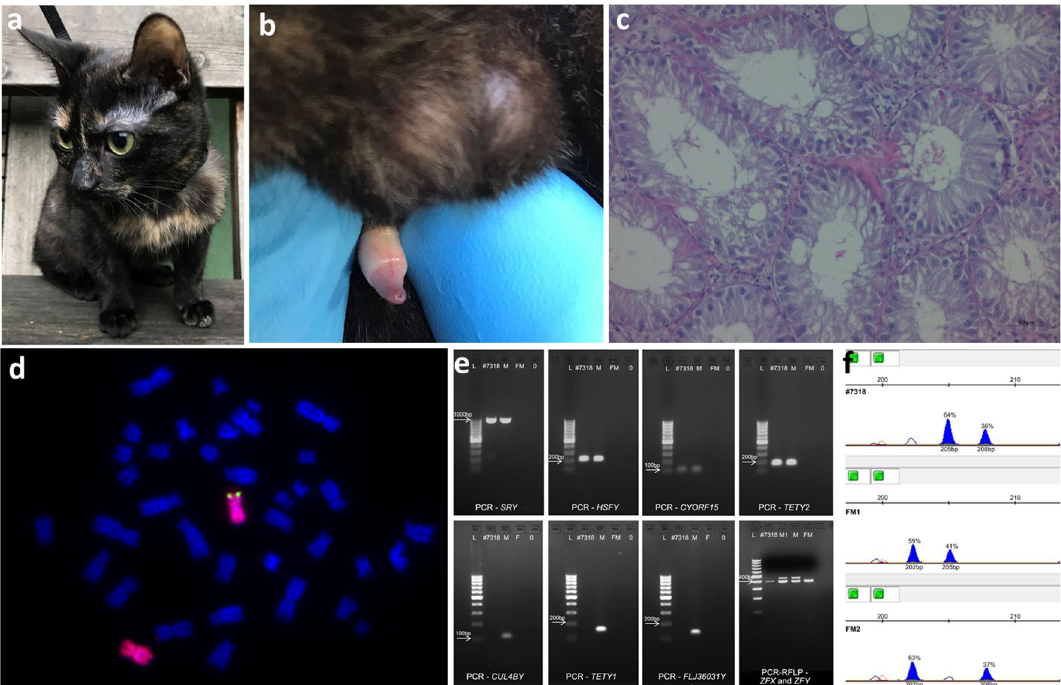
Figure 1. Characteristics of DSD case #7318: ( a ) tricolored coat pattern; ( b ) male external genitalia with bifid scrotum; ( c ) histology of gonads: testes with seminiferous tubules with normal Sertoli cells, normal Leydig cells, and lack of germinal cells; ( d ) FISH showing the SRY gene (green) on the X chromosome (red); ( e ) detection of genes translocated on the X chromosome. The Yp-linked genes were amplified for the DSD cat ( SRY, HSFY, CYORF15, TETY2, ZFY ) and the Yq-linked genes were absent ( CUL4BY , TETY1 and FLJ36031Y ). L: 100–1000 bp ladder, DSD case #7318, M: control male; FM: control female; 0: negative control; ( f ) random inactivation pattern of X chromosomes in case #7318 and two control females, FM1 and